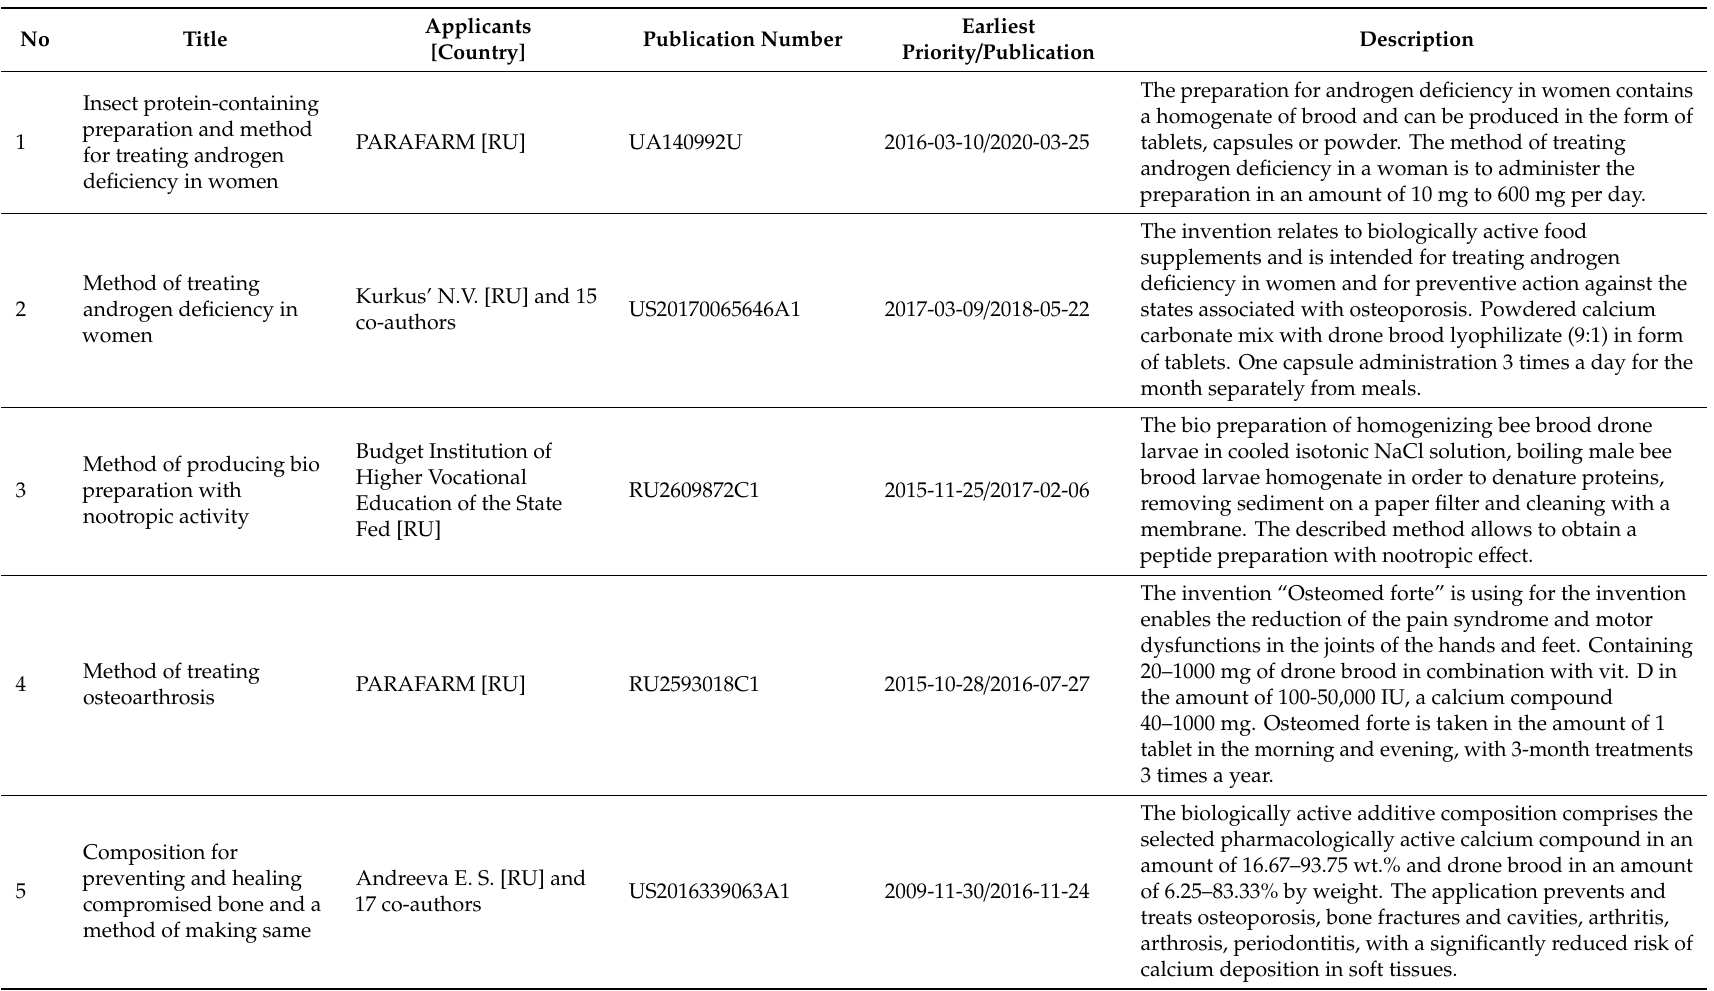
Table 5. Patents relating to the use of drone brood as an ingredient in supplements in the prevention / treatment of various health problems [https: // worldwide. espacenet.com /